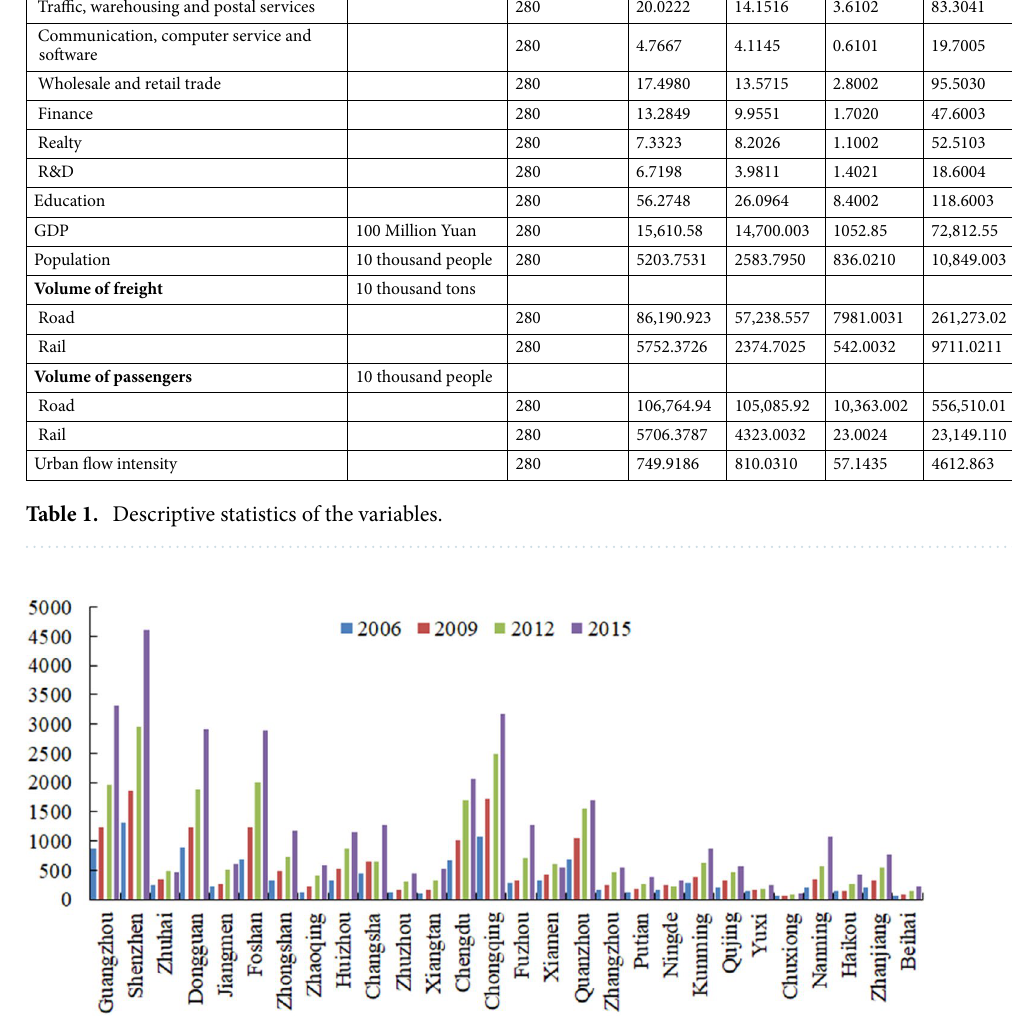
Figure 1. The urban flow density of the Pearl River Delta (2006, 2009, 2012,